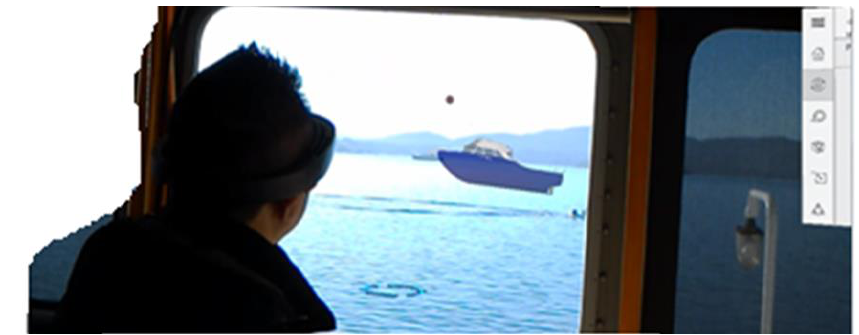
Figure 3. Projected view of fishing boat at AMC Surface Vessel Bluefin at angle of 75.6°.